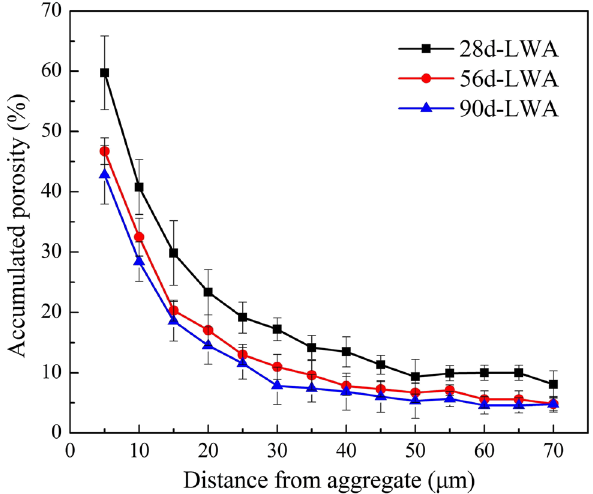
Figure 7: The porosity pro fi le starting from aggregate surface at di ff erent hydration ages [ 39 ]